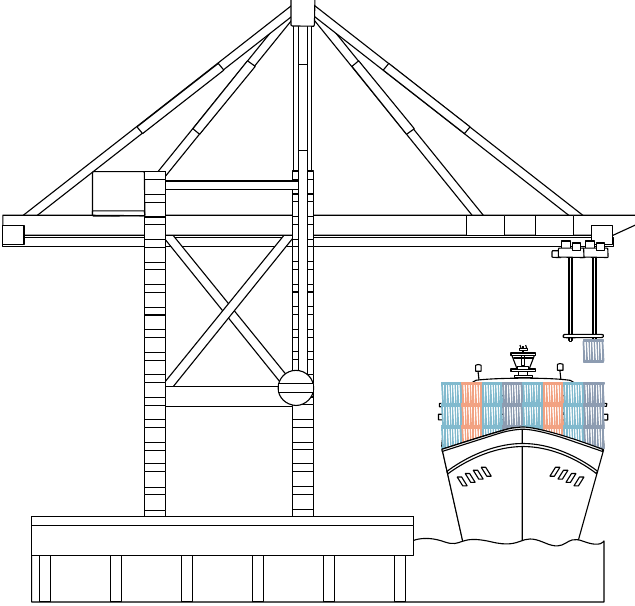
Figure 3. Operation of twin 40-foot QCs with different